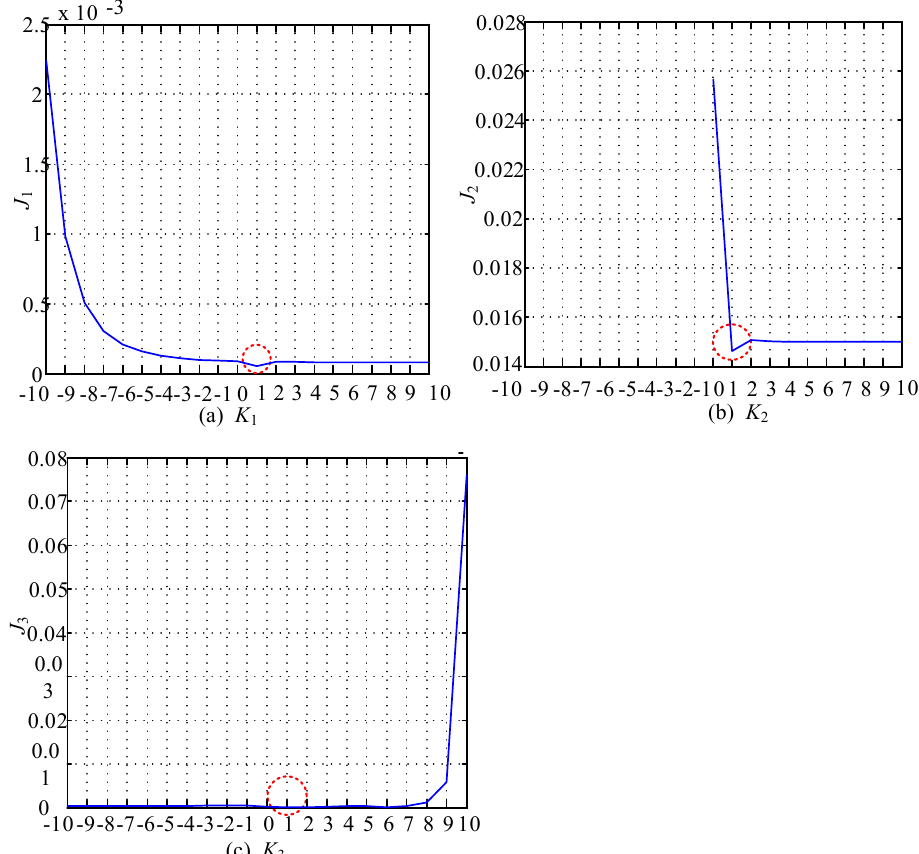
Figure 7. The curve of J 1 , J 2 , and J 3 varying with K 1 , K 2 , and K 3 , respectively: ( a ) the curve of J 1 varying with K 1 ; ( b ) the curve of J 2 varying with K 2 ; ( c ) the curve of J 3 varying with K 3 .